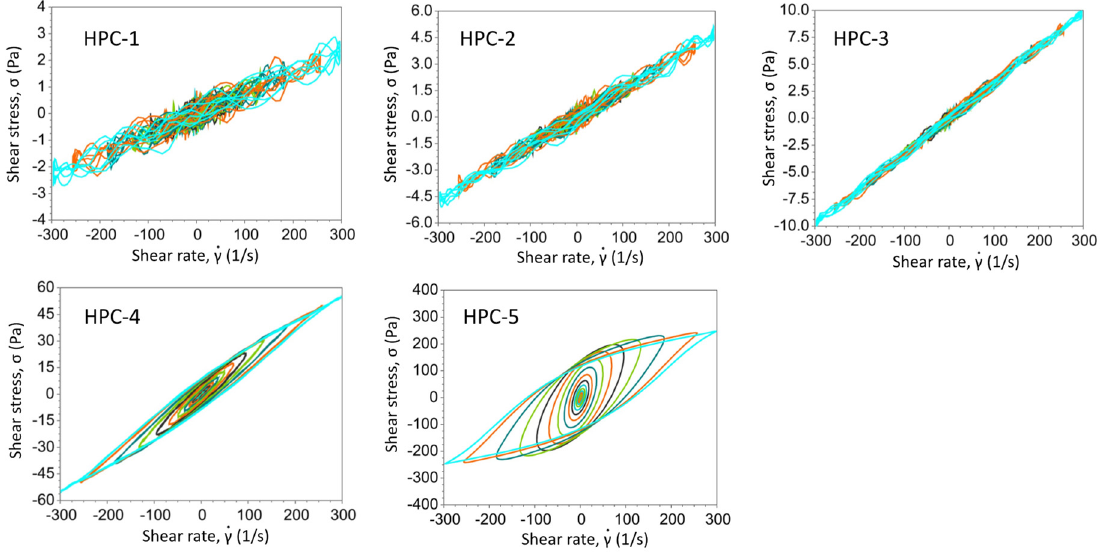
Figure 7. Lissajous–Bowditch curves for HPC-1, HPC-2, HPC-3, HPC-4, and HPC-5.